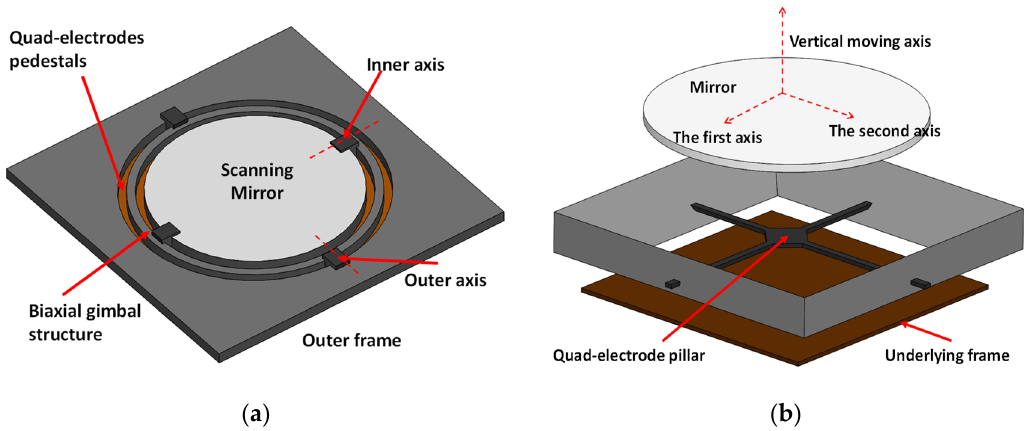
Figure 3. Mechanical structures of ( a ) the MEMS scanner using quad-electrodes to achieve a 2D scan with a gold-coated mirror [26] and ( b ) the quad-electrode pillar utilized to drive the mirror combined with electrostatic actuation between the mirror and bottom basement for 3D imaging